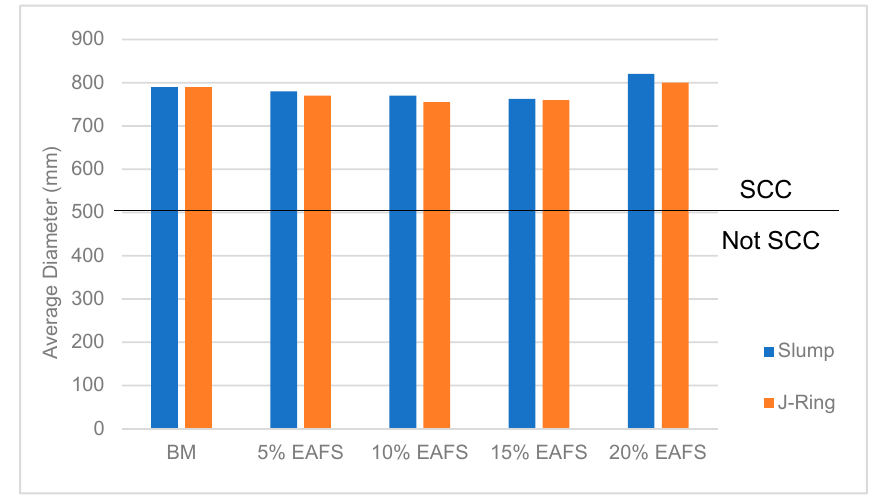
Figure 11. Results of the J-Ring flow and slump flow for SCC samples containing varying doses of EAFS.